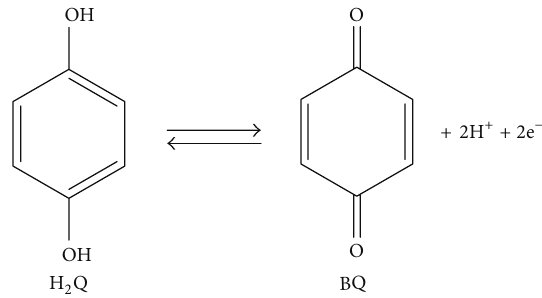
Figure 2: The redox reaction between H 2 Q and